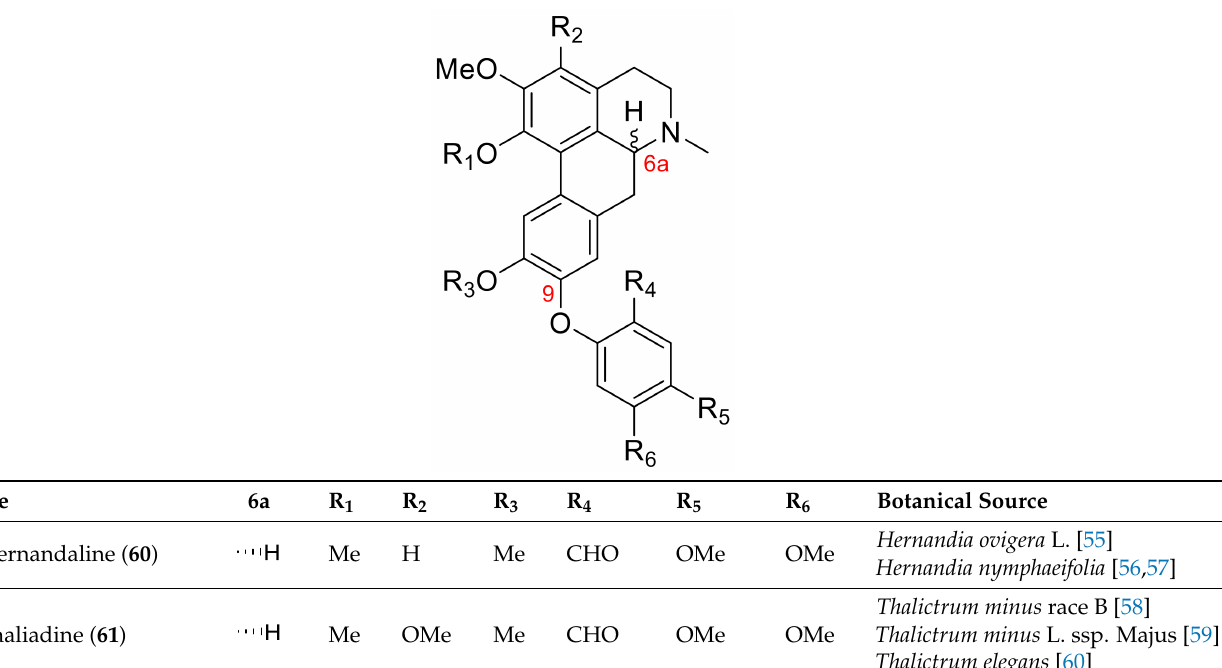
Table 6. Aporphine–phenyl dimeric alkaloids (hernandaline type). Table 6. Aporphine – phenyl dimeric alkaloids (hernandaline Table 6. Aporphine – phenyl dimeric alkaloids (hernandaline type).